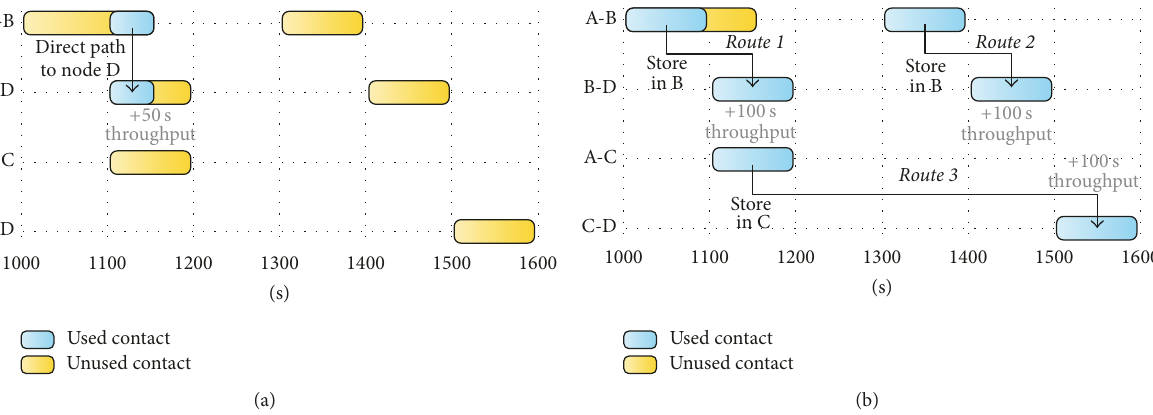
Figure 1: DTN topology example. Effective throughput with (a) Internet protocols and (b) DTN